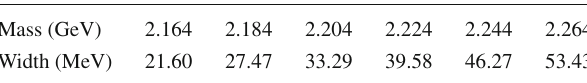
Table 3 The decay widths of X a → D s π 0 ( β = 0 . 4395 GeV) Mass